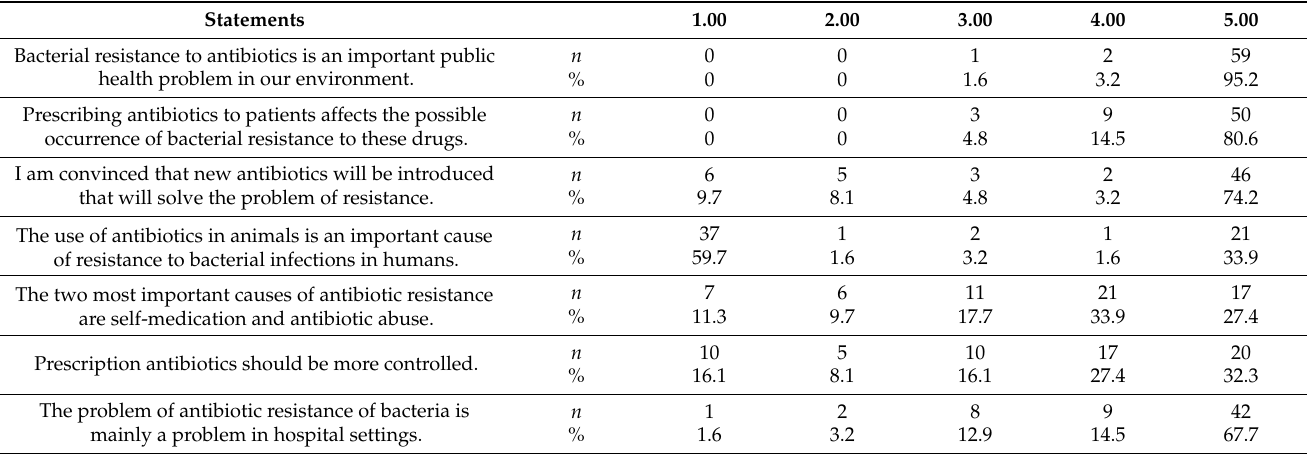
Table 2. Knowledge of antimicrobial resistance (1-strongly disagree; 2-disagree; 3-neither agree nor disagree; 4-agree; 5-strongly agree).